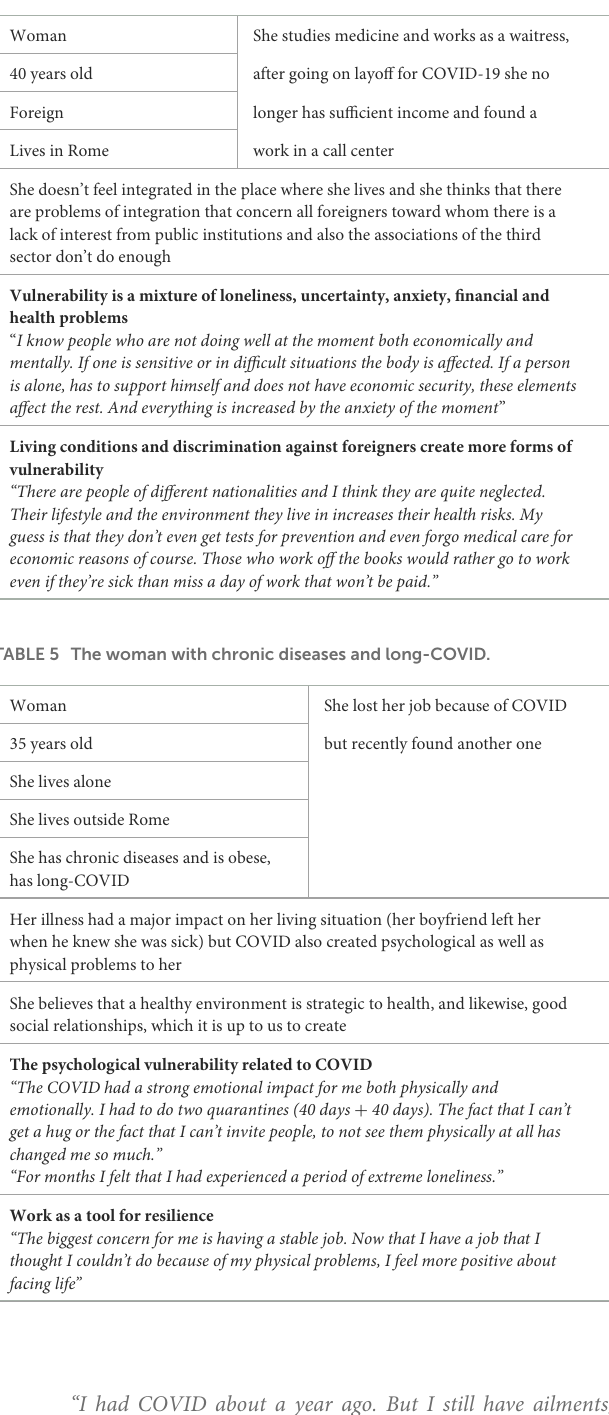
TABLE 3 Compounded vulnerabilities (val.%). TABLE 4 The non-integrated foreign woman.